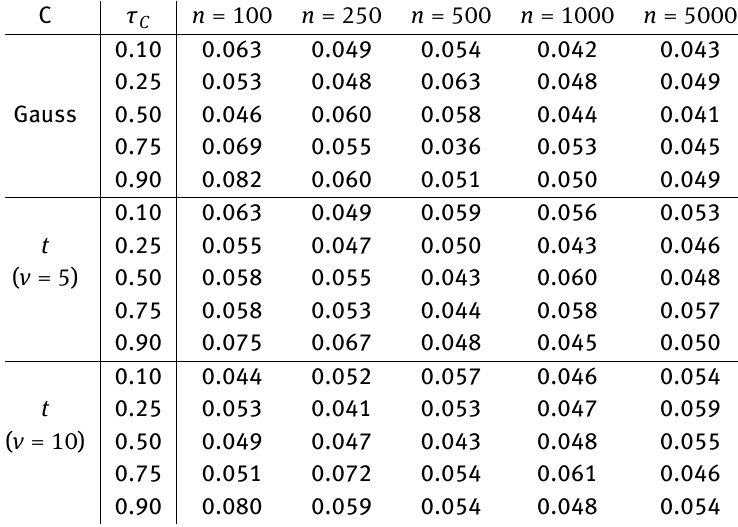
Table 11: d = 2 : Empirical level of the test for ellipticity with significance level α = 0.05 based on the test statistic T n : rate of rejecting H 0 as observed in 1000 random samples of pseudo-observations of size n from copula family C with Kendall’s tau τ C